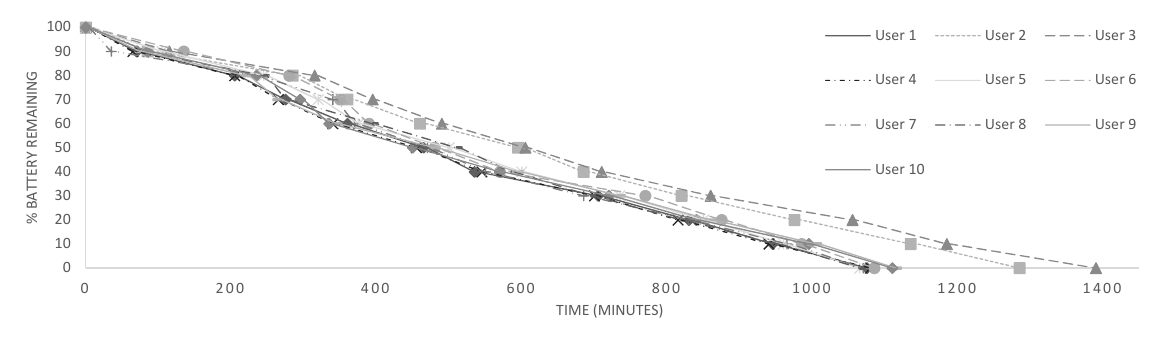
Figure 9. Analysis of battery lifetime through different user